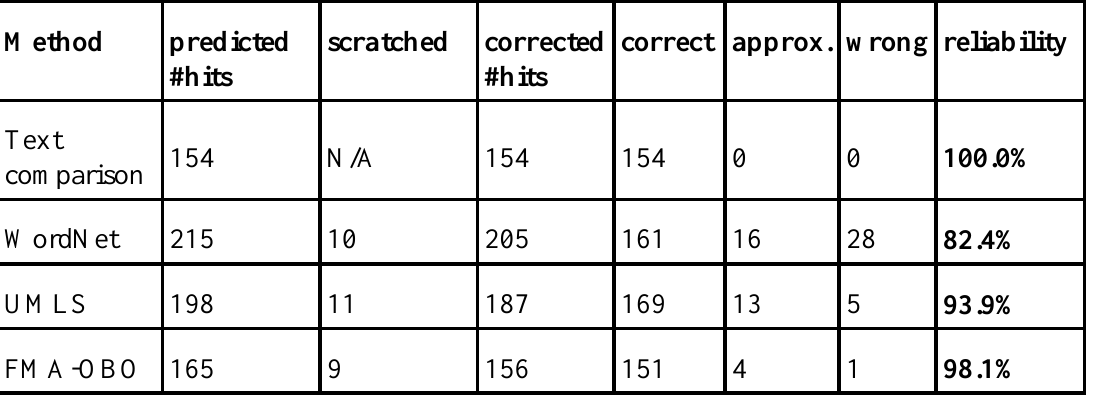
Table 1: Analysis of predicted synonyms